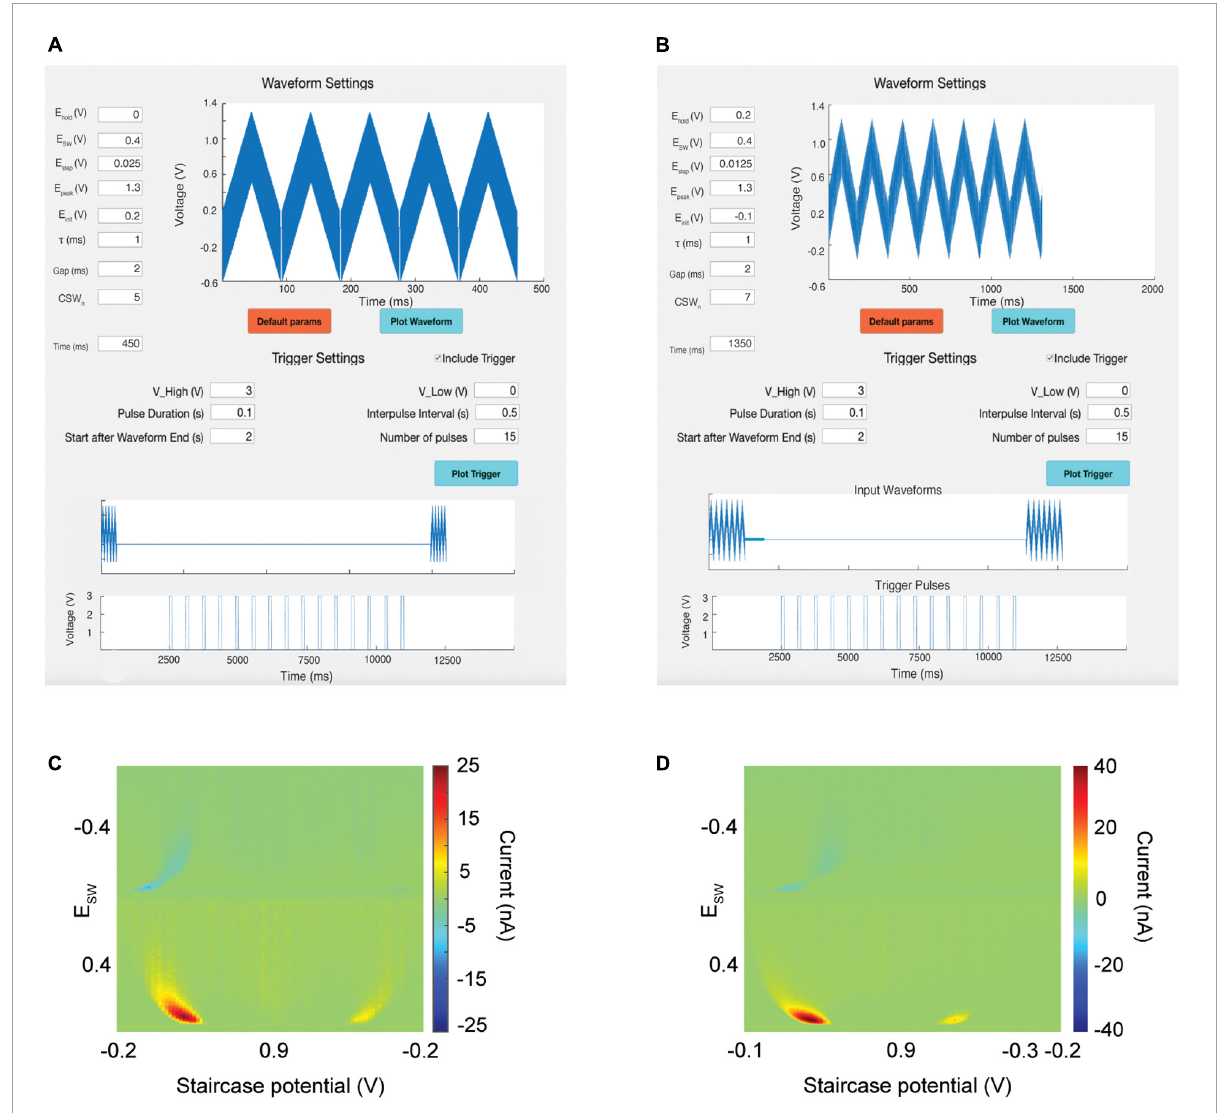
FIGURE2 Waveform and trigger designer tool. Top: Users can create their own waveforms or choose from among a default set. Middle: Users can create their own trigger pulses to power external devices. The software time syncs the trigger pulses with input waveforms to avoid overlap. (A) M-CSWV waveform for detection of dopamine. (B) N-MCSWV waveform for detection of serotonin. (C) Output pseudocolor plot demonstrating detection of 500 nM of dopamine. (D) Output pseudocolor plot demonstrating detection of 100 nM of